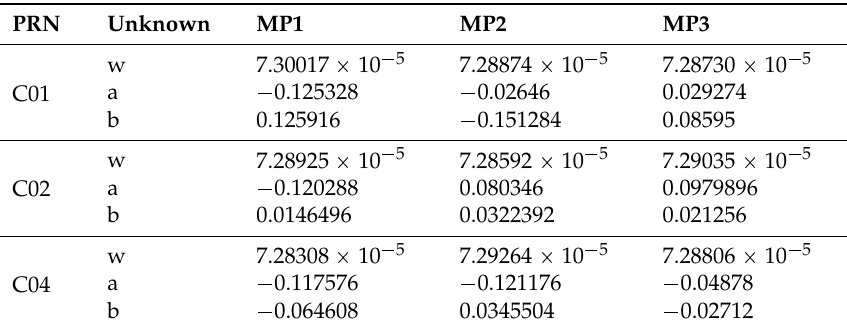
Table 1. The unknown estimations in Equation